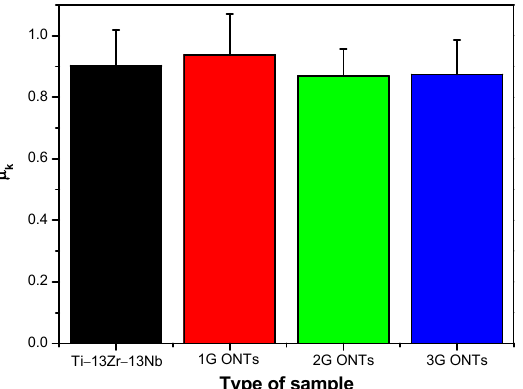
Figure 10. Kinetic coefficient of friction ( µ k ) obtained in the tribological wear test using the ball-on-flat system for the Ti–13Zr–13Nb alloy before and after anodizing.